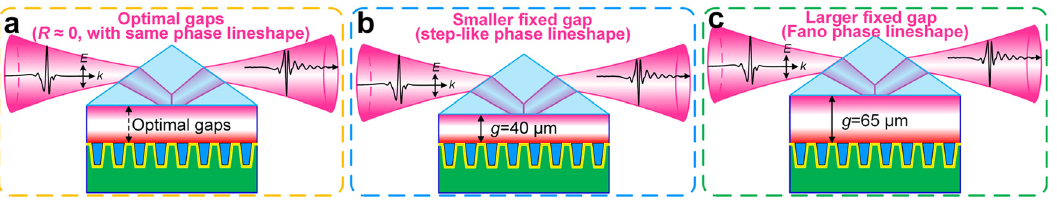
Figure 6: Schematic diagrams of three coupling gaps controlled sensing methods for liquids. (a) Adjusting gaps to their own optimal levels, i.e., R ≈ 0andallphase-jumpsexhibitthesamelineshape.(b)Thegapis fi xedatasmallervaluetoformstep-likephaselineshape,and(c)The gap is fi xed at a larger value to form Fano phase